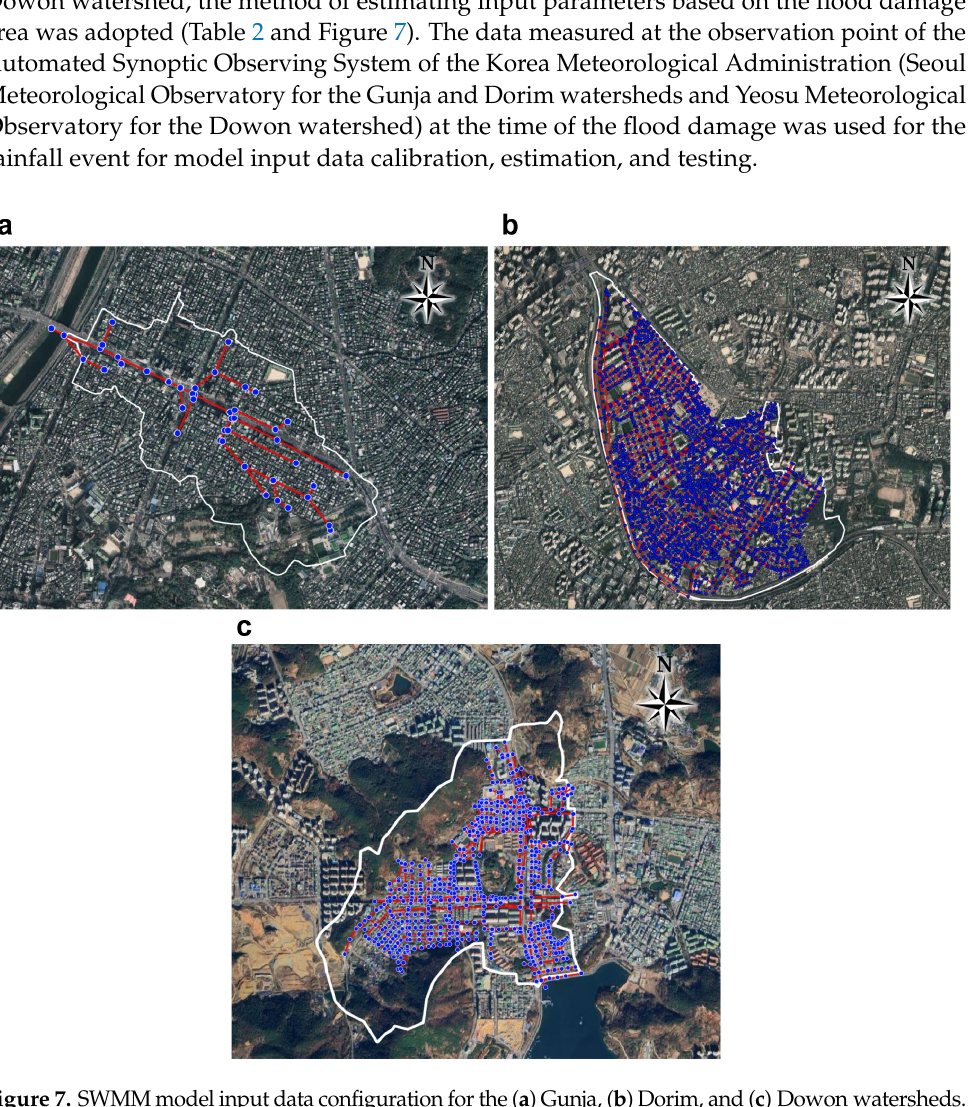
Figure 7. SWMM model input data configuration for the ( a ) Gunja, ( b ) Dorim, and ( c ) Dowon wa- tersheds .